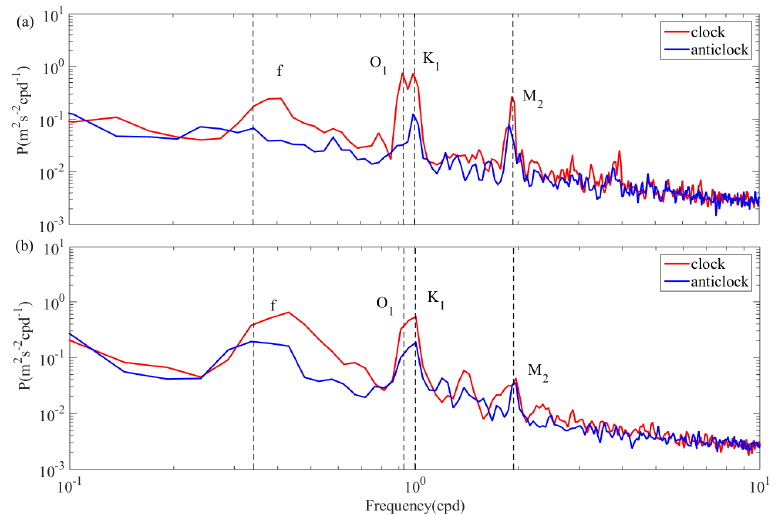
Figure 4. Spectra for clockwise (red) and anticlockwise (blue) components of the depth-averaged WKB-scaled velocity during January ( a ) and December ( b ) 2010.